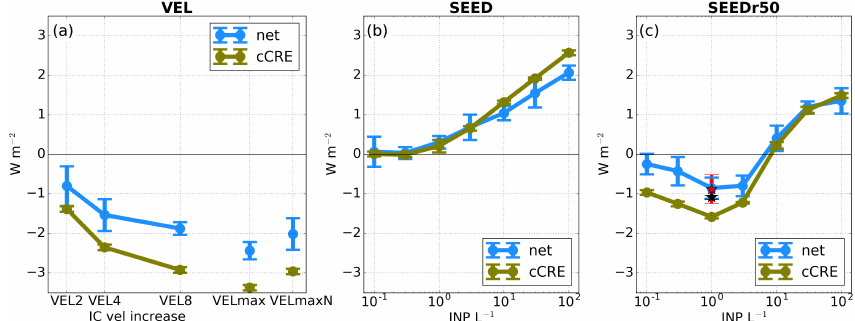
Figure 2. Five-year TOA anomalies of net radiative fluxes (NET) and net cirrus cloud radiative effects (cirrus CRE) from fixed SST simula- tions of seeding with increased sedimentation velocities (a) . Panel (b) shows net radiative fluxes and cirrus CRE for seeding simulations with different 0.5µm sized INPs, while (c) shows the equivalent for seeding with 50µm INPs. The stars in (c) show results from the SEED1r50N simulation with seeding performed only at night, where the red star represents the net anomaly and the black one cirrus CRE anomaly. The error bars represent ± 2 standard deviations.